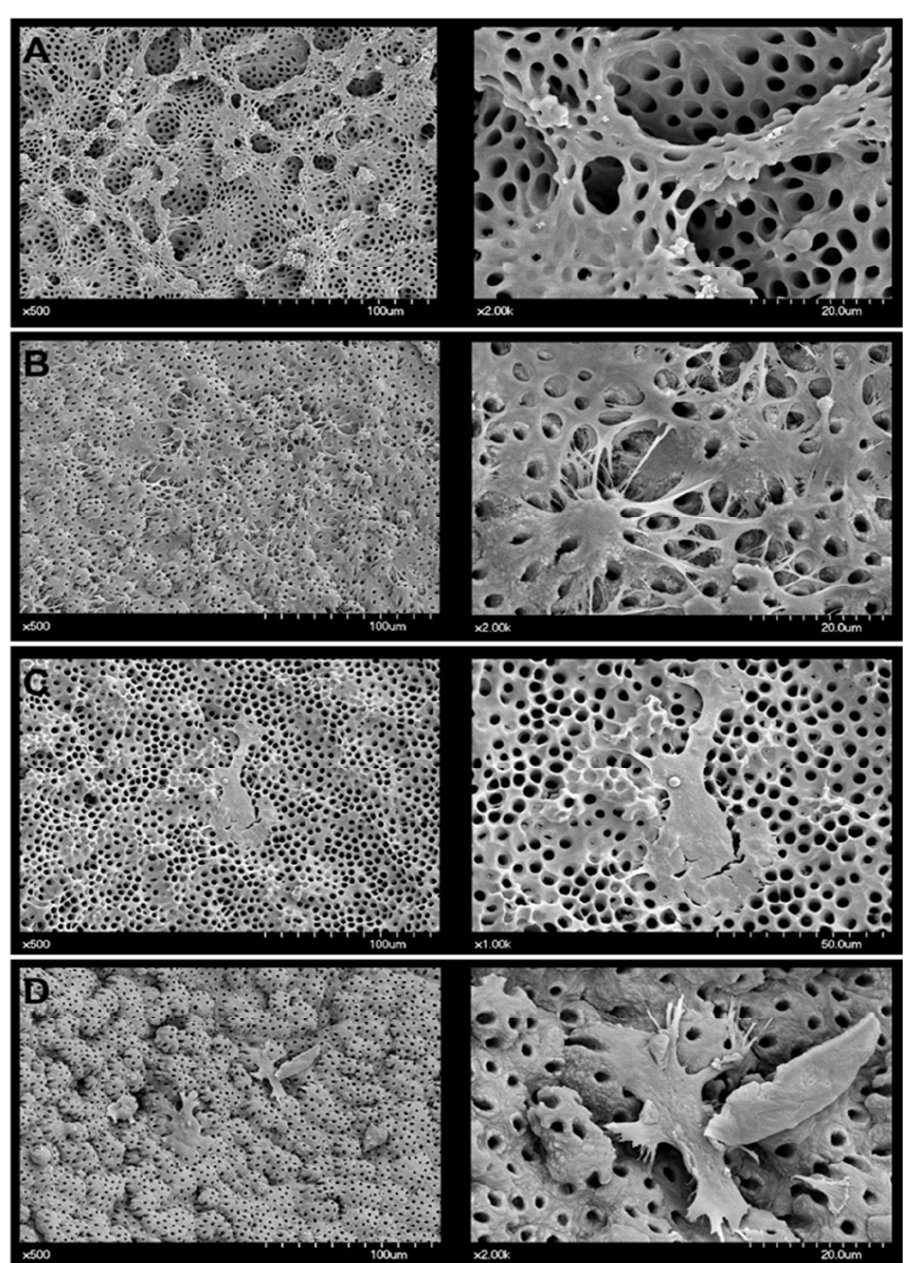
Figure 3. hDPSCs attachment and spreading on dentin slices observed through scanning electron microscopy (left, ×500; right, ×2000). ( A ) Group I (NaOCl + EDTA + NTAPP): Numerous hDPSCs had attached and spread out onto dentin surfaces in multiple layers, entangled by long cytoplasmic processes. ( B ) Group II (NaOCl + NTAPP): hDPSCs had formed multilayer structures on dentin. ( C ) Group III (NaOCl + EDTA): Fewer hDPSCs had spread out onto dentin without multilayers. ( D ) Group IV (control, NaOCl only): Few isolated hDPSCs had attached to dentin.